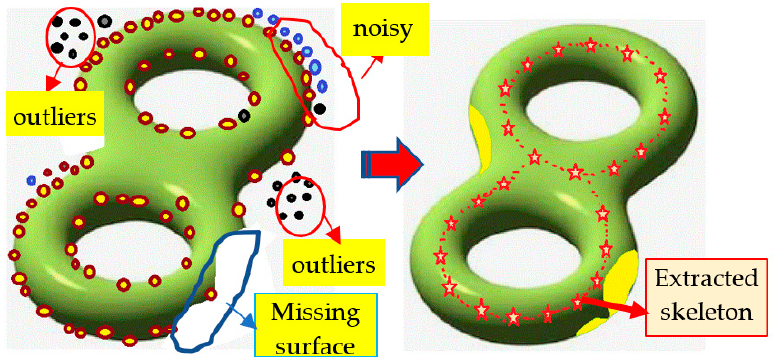
Figure 7. Skeleton extraction scheme.